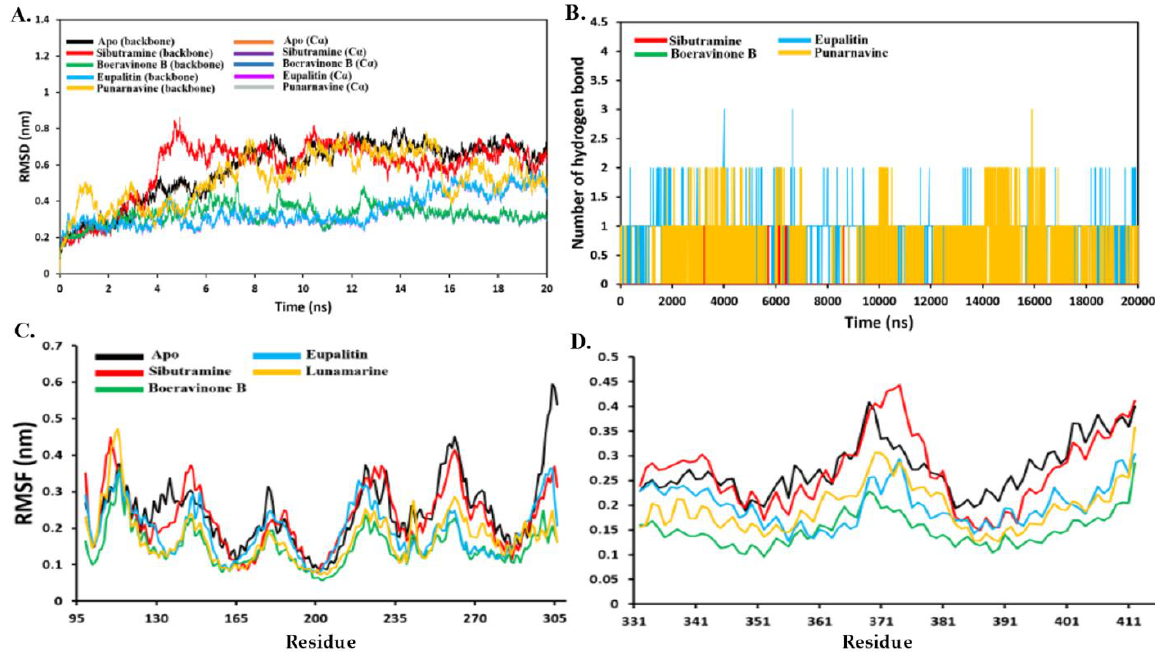
Figure 8. ( A ) The RMSD of the whole backbone atoms and alpha-carbon atoms (C α ) and for apo CB1 receptor and CB1 – ligand complexes. ( B ) Several hydrogen bonds formed during the period of 20 ns MD simulation. ( C ) Residue flexibility analysis by RMSF per residue with a focus on 101 – 300 and in figure ( D ) at 333 – 410 residues.